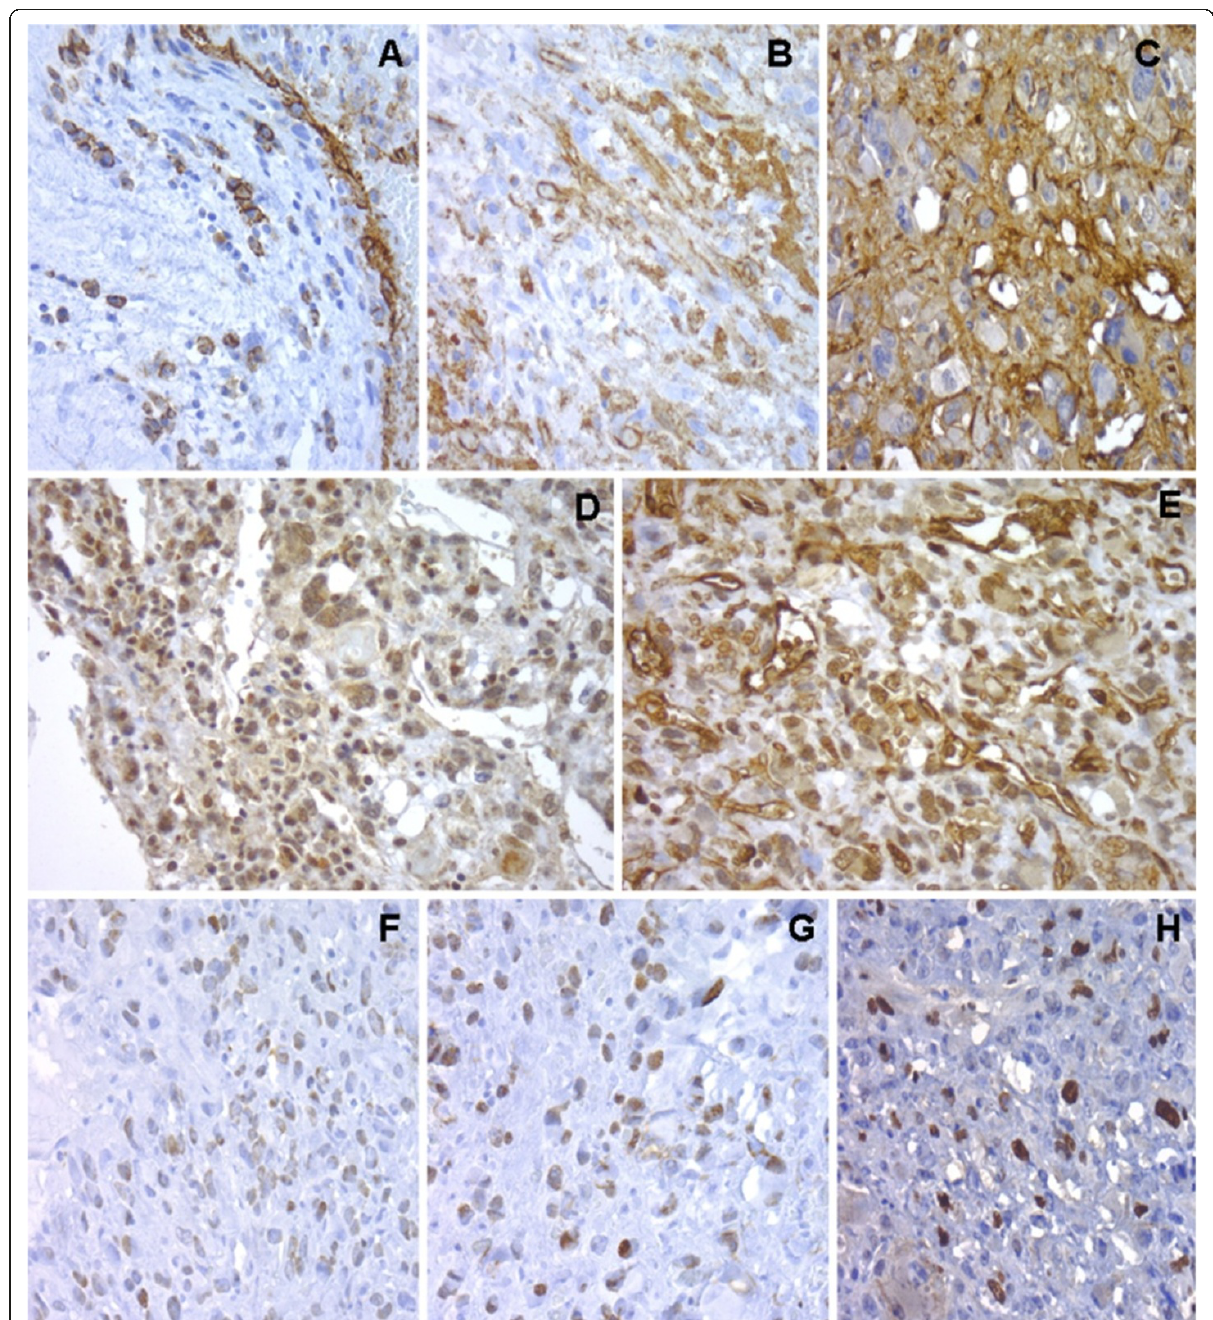
Figure 4 Pulmonary artery angiosarcoma. A . CD31 expression in tumor cells. B . CD34 highlights tumor cells. C . Strong positivity for Factor VIII. D . FLI-1 shows nuclear expression. E . Ulex europaeus positive staining. F . FGF expression. G . Ki67 nuclear staining. H . p53 nuclear